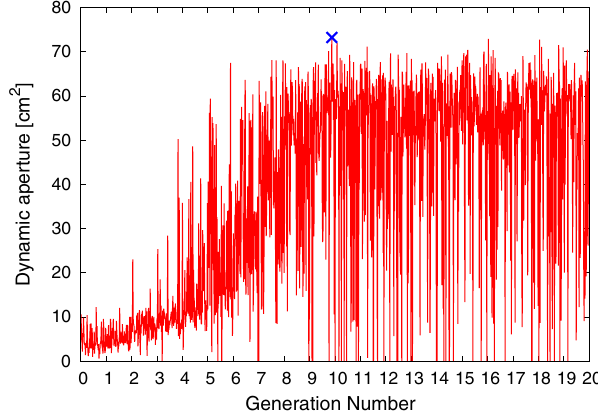
FIG. 8. Dynamic aperture after the linear chromaticity com- pensation for the initially chosen working point of ð (cid:3) x ; (cid:3) y Þ ¼ ð 0 : 31 ; 0 : 32 Þ